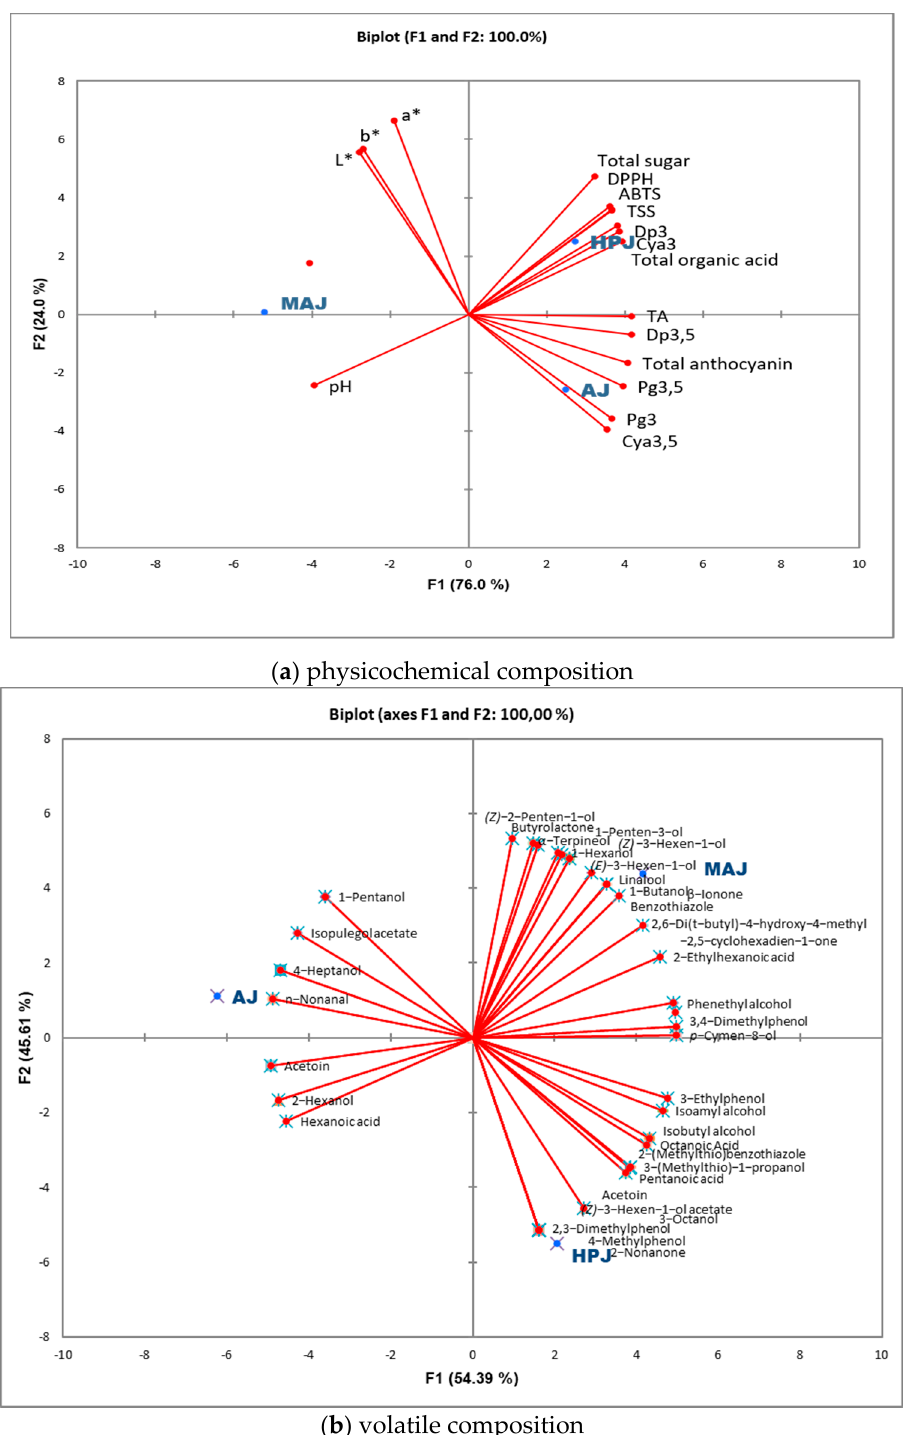
Figure 3. PCA biplots of ( a ) physicochemical (first plot) and ( b ) volatile composition (second plot) of pomegranate juice samples (AJ—arils juice, HPJ—halved pomegranate juice, MAJ—macerated arils juice).